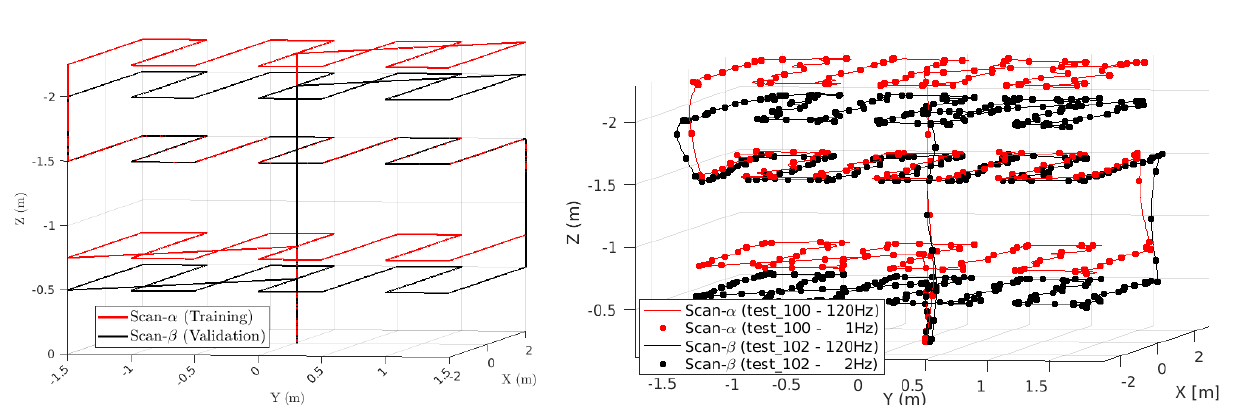
Figure 6. Scan- α and Scan- β : coverage patterns to train and validate the magnetic field map for the indoor